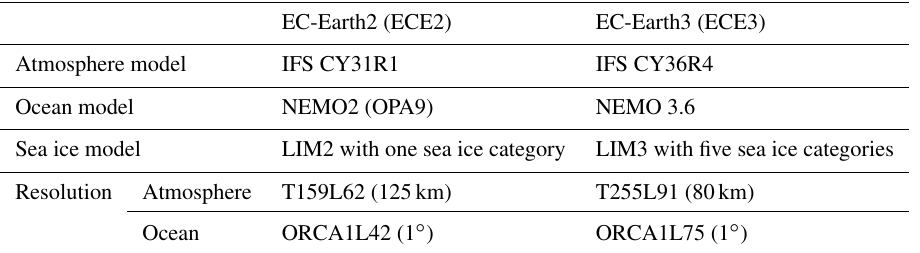
Table 1. CMIP5 and CMIP6 versions of the EC-Earth model